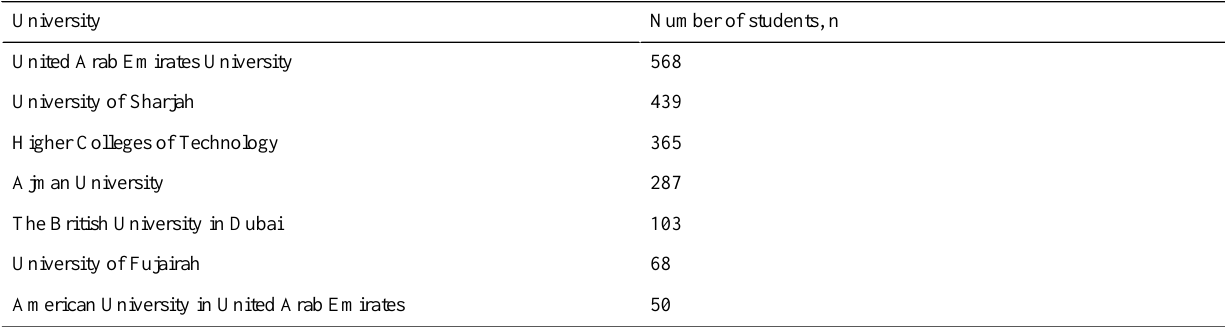
Table 1. Number of students (N=1880) in participating universities.